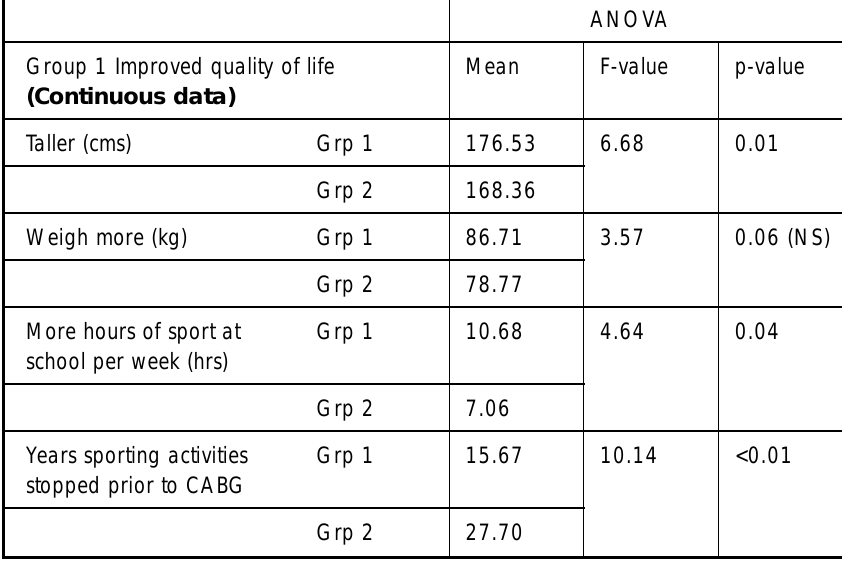
Table 1V: On admission into the trial (Continued).